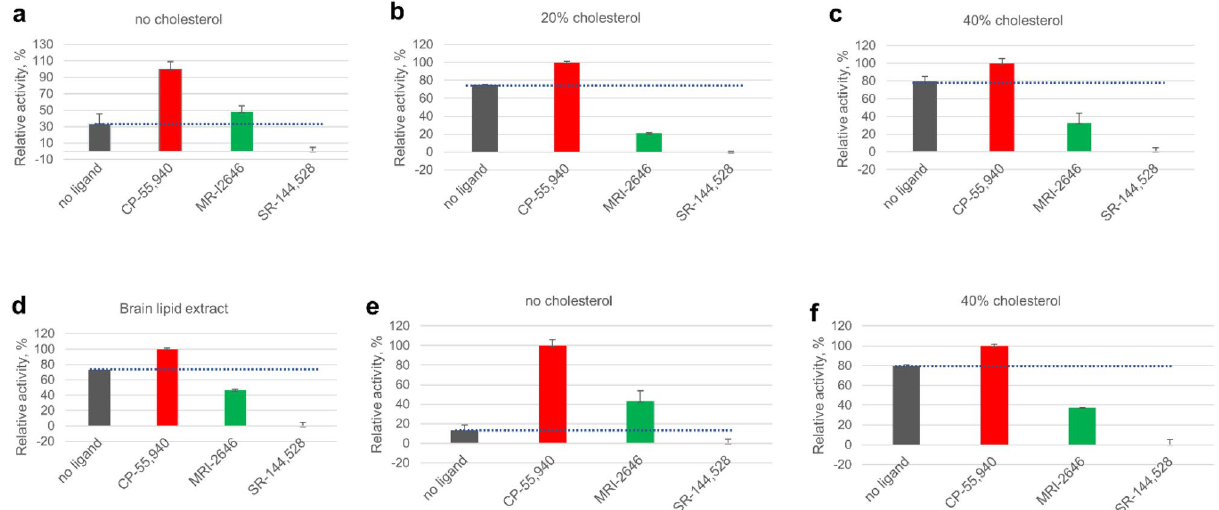
Figure 7. Activation of G protein on CB 2 receptor reconstituted in liposomes. Liposome composition: 75% POPC, 25% POPG and cholesterol content relative to total phospholipids as indicated, or total lipids extracted from bovine brain, as indicated. Proteins were reconstituted at a protein-to-lipid ratio in the range 1:850 to 1:1100 mol/mol. ( a – d ) CB 2 purified from E. coli cells. ( e , f ) CB 2 purified from Expi293F GNTI - cells. Average values of four independent measurements are plotted (n = 4). Dotted lines represent the rates of activation of G protein in the absence of a